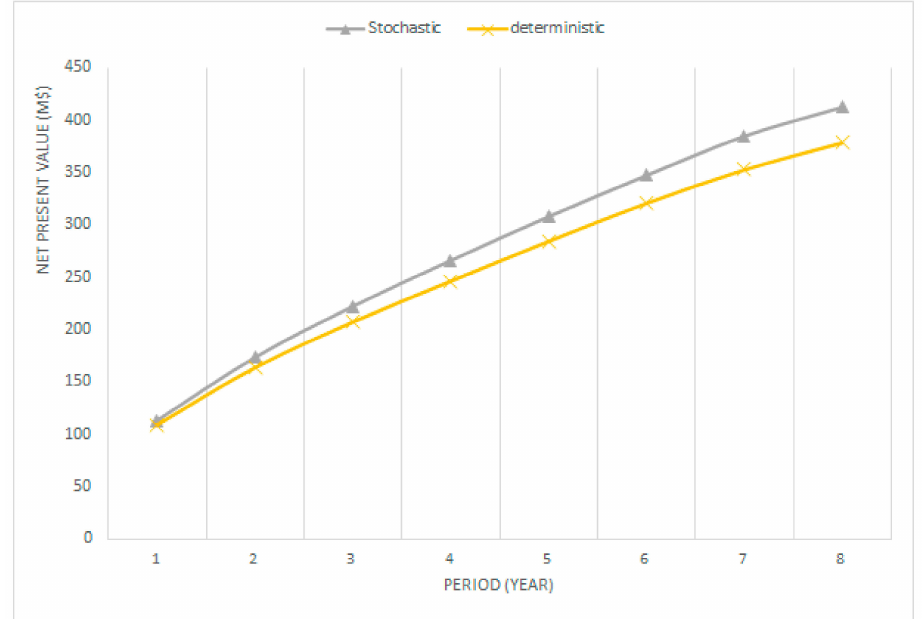
Figure 12. Comparison of undiscounted cumulative cash flow with a deterministic